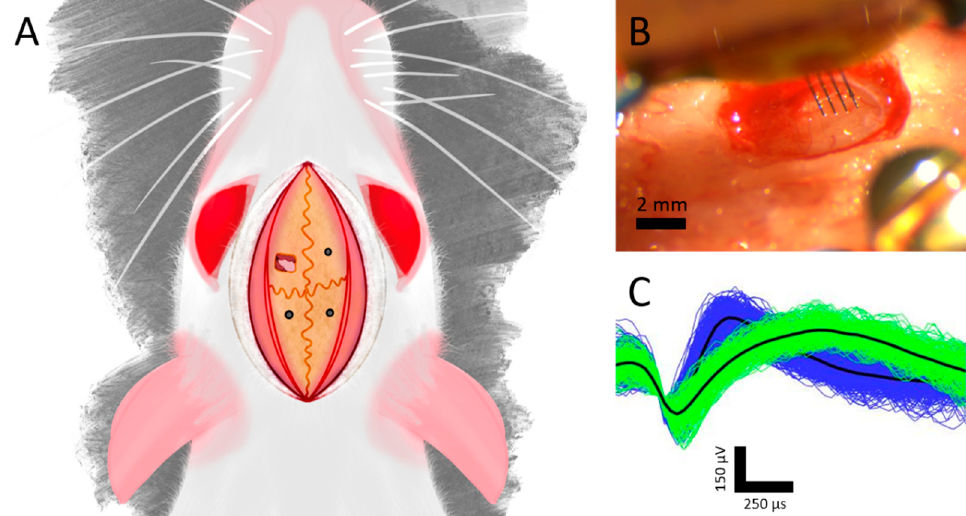
Figure 2. Neuronal data acquisition and analysis. ( A ) Implantation schematic with a craniotomy over the left motor cortex and bone screws in the adjacent quadrants. ( B ) Representative image during a multi-shank implantation. ( C ) Representative single units recorded simultaneously from the same microelectrode of a single shank device.